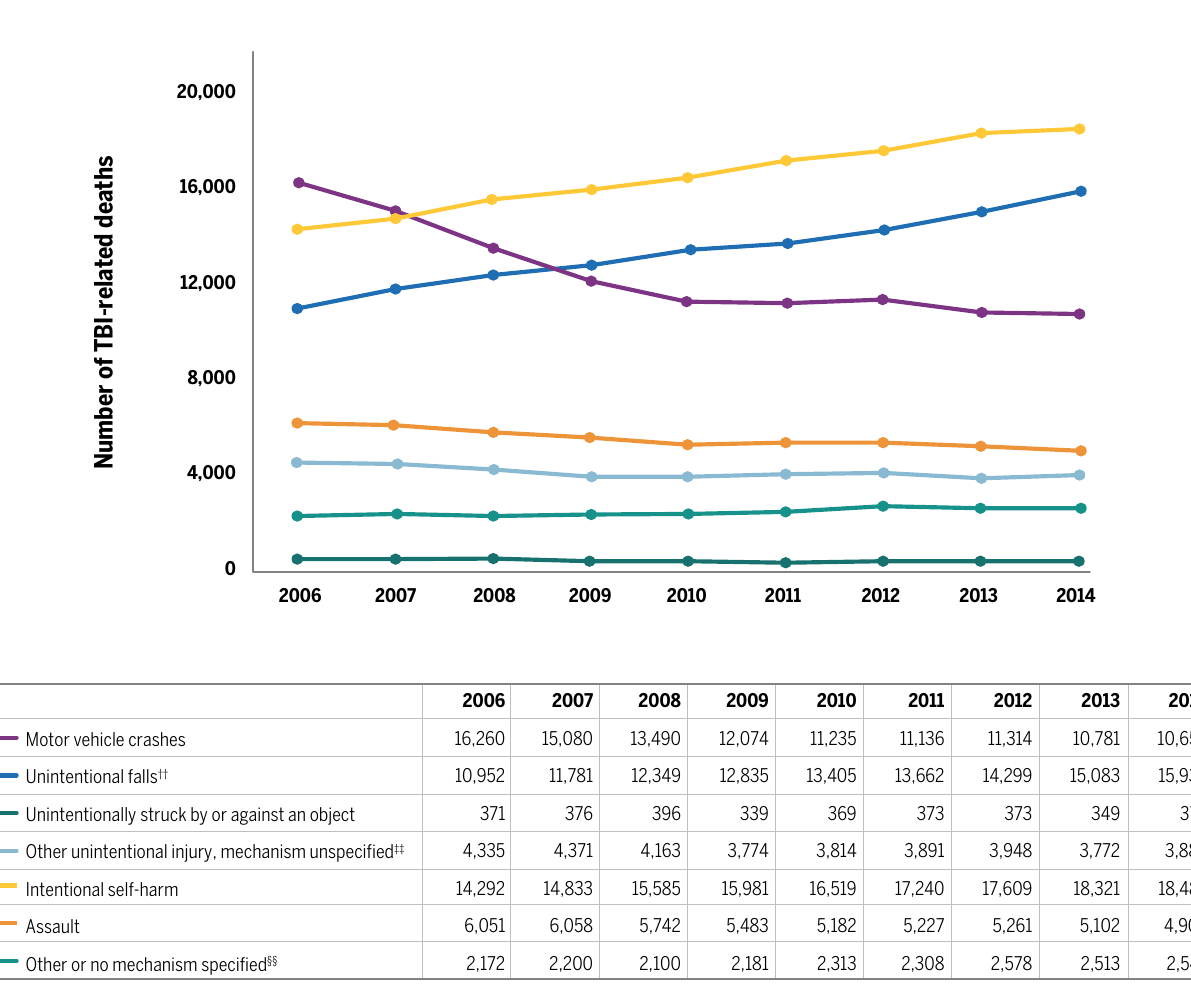
FIGURE 4B: NUMBER OF TRAUMATIC BRAIN INJURY–RELATED DEATHS, BY YEAR AND MECHANISM OF INJURY,